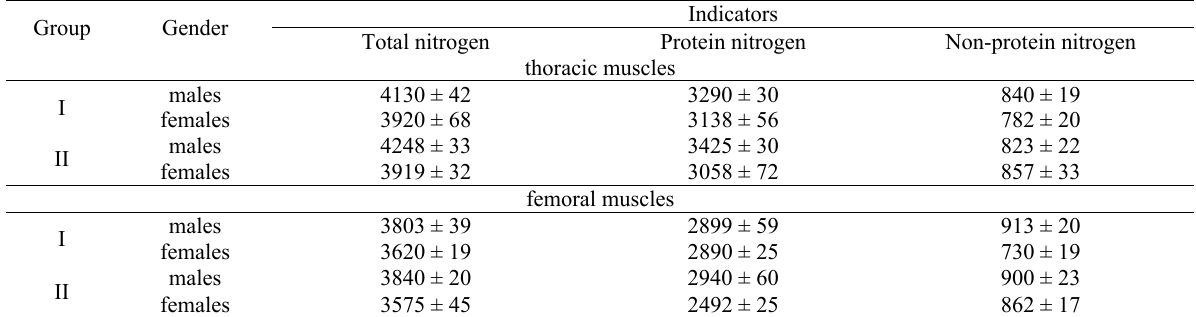
Content of total, protein and non-protein nitrogen in the femoral and thoracic muscles of geese at 9 weeks of age, mg